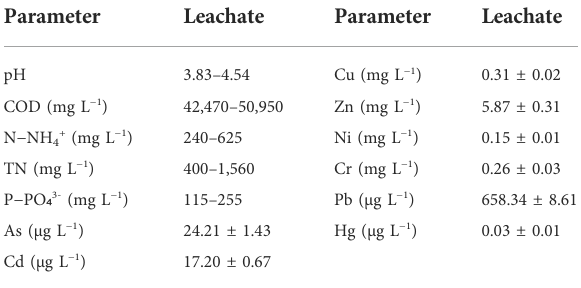
TABLE 1 Typical characteristics of leachate used in this